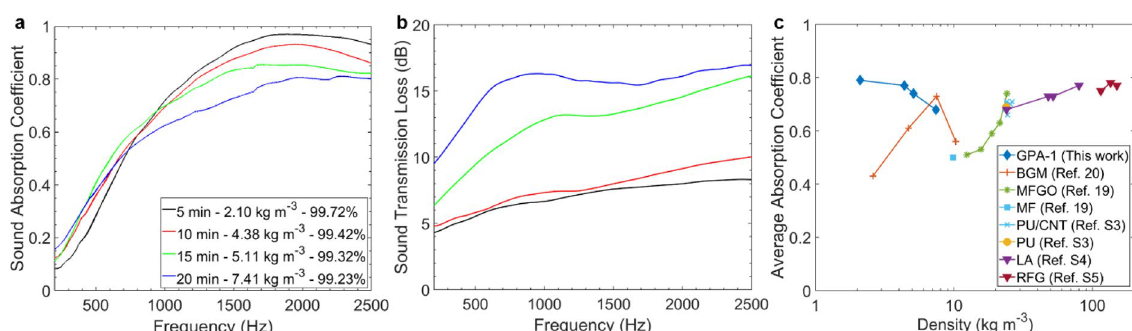
Figure 5. Effects of processing time and densities on acoustic properties of GPA-1 samples: ( a ) sound absorption and ( b ) sound transmission loss. Key and average α and STL values are summarised in Table S4. ( c ) Comparison of the average sound absorption coefficient, calculated in the 400–2500 Hz range, as a function of density for GPA-1 samples and other porous absorbers with comparable thickness previously reported in literature (Table